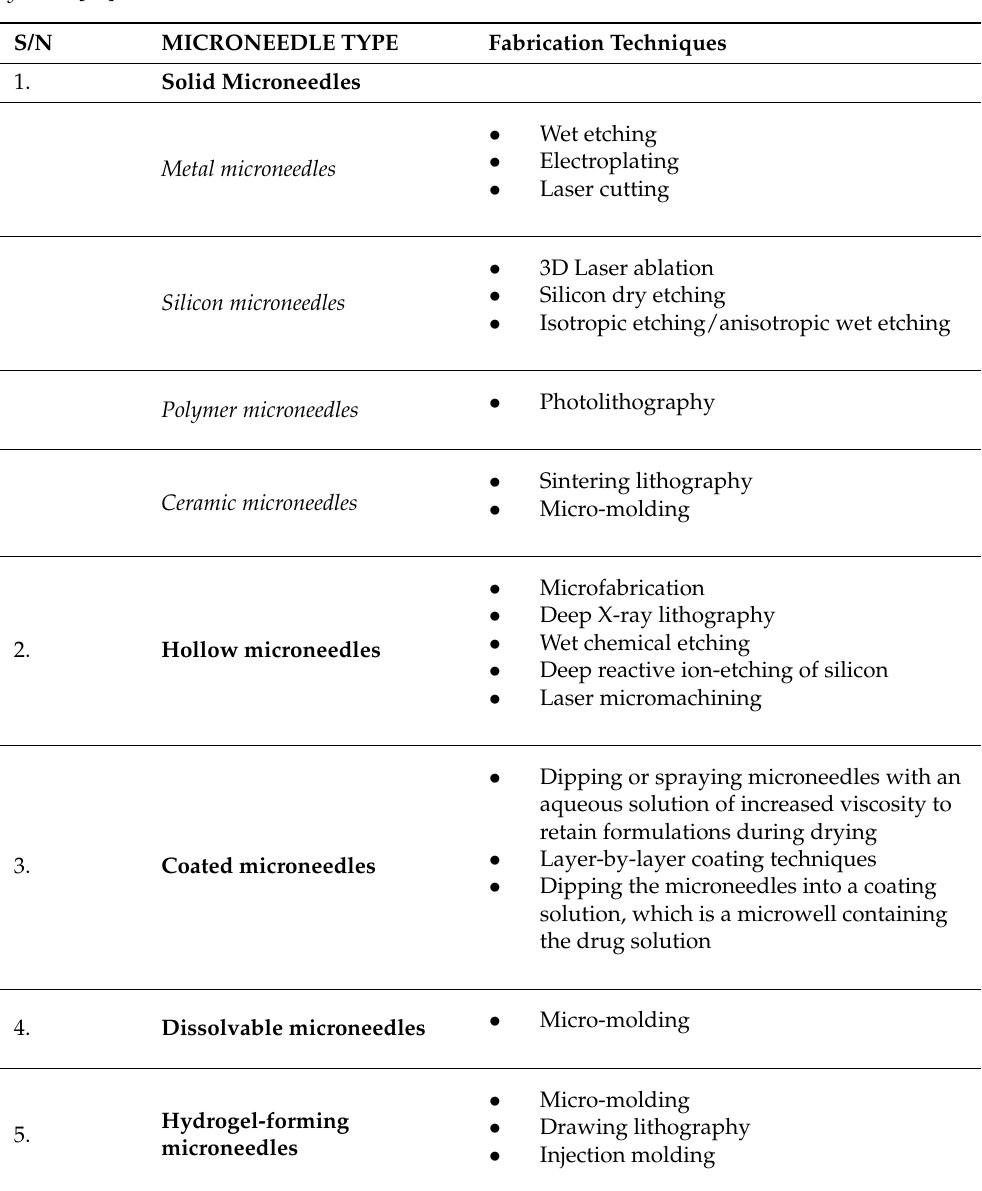
Table 2. Source: “ Microneedles: A smart approach and increasing potential for transdermal drug delivery system ”